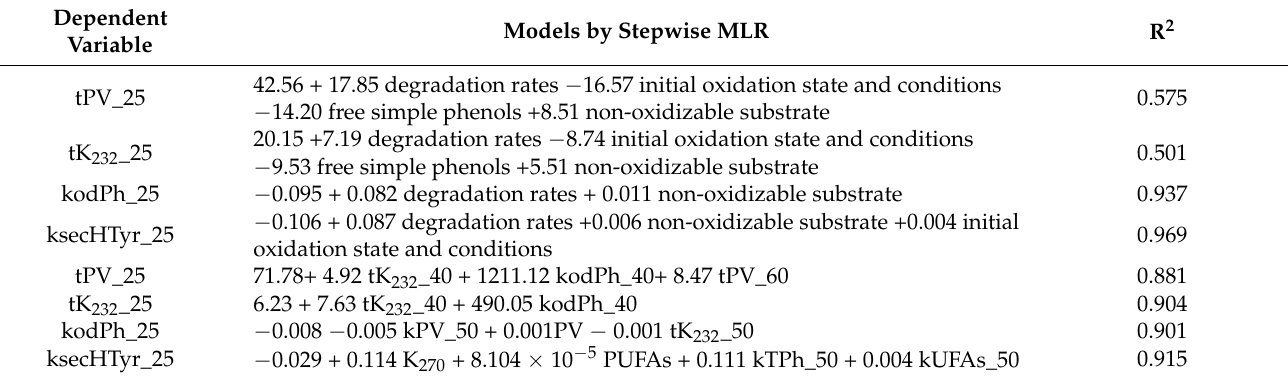
Table 6. Proposed predictive